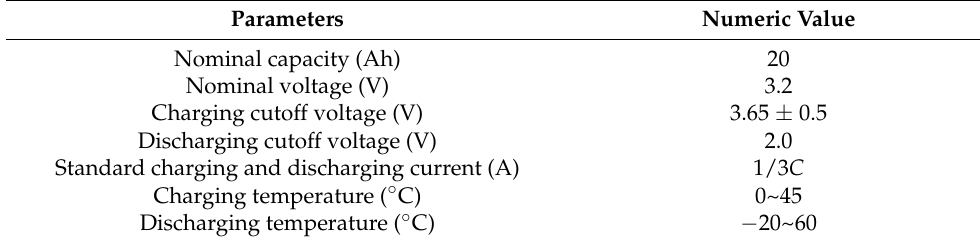
Table 2. Basic performance parameters of experimental